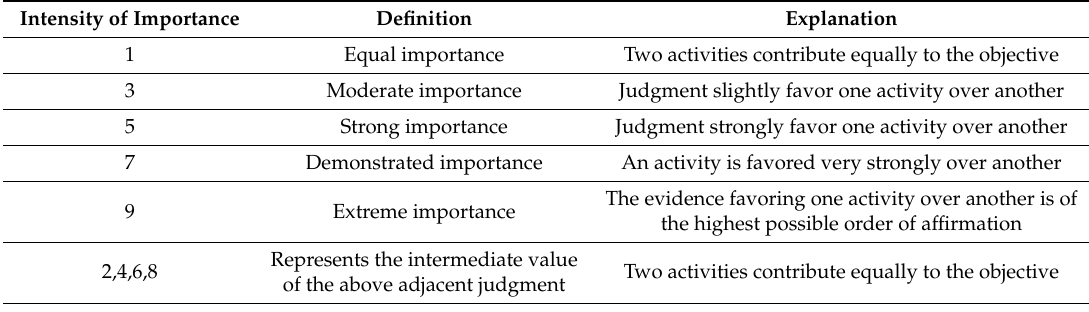
Table 2. Importance scale of factors in pair-wise